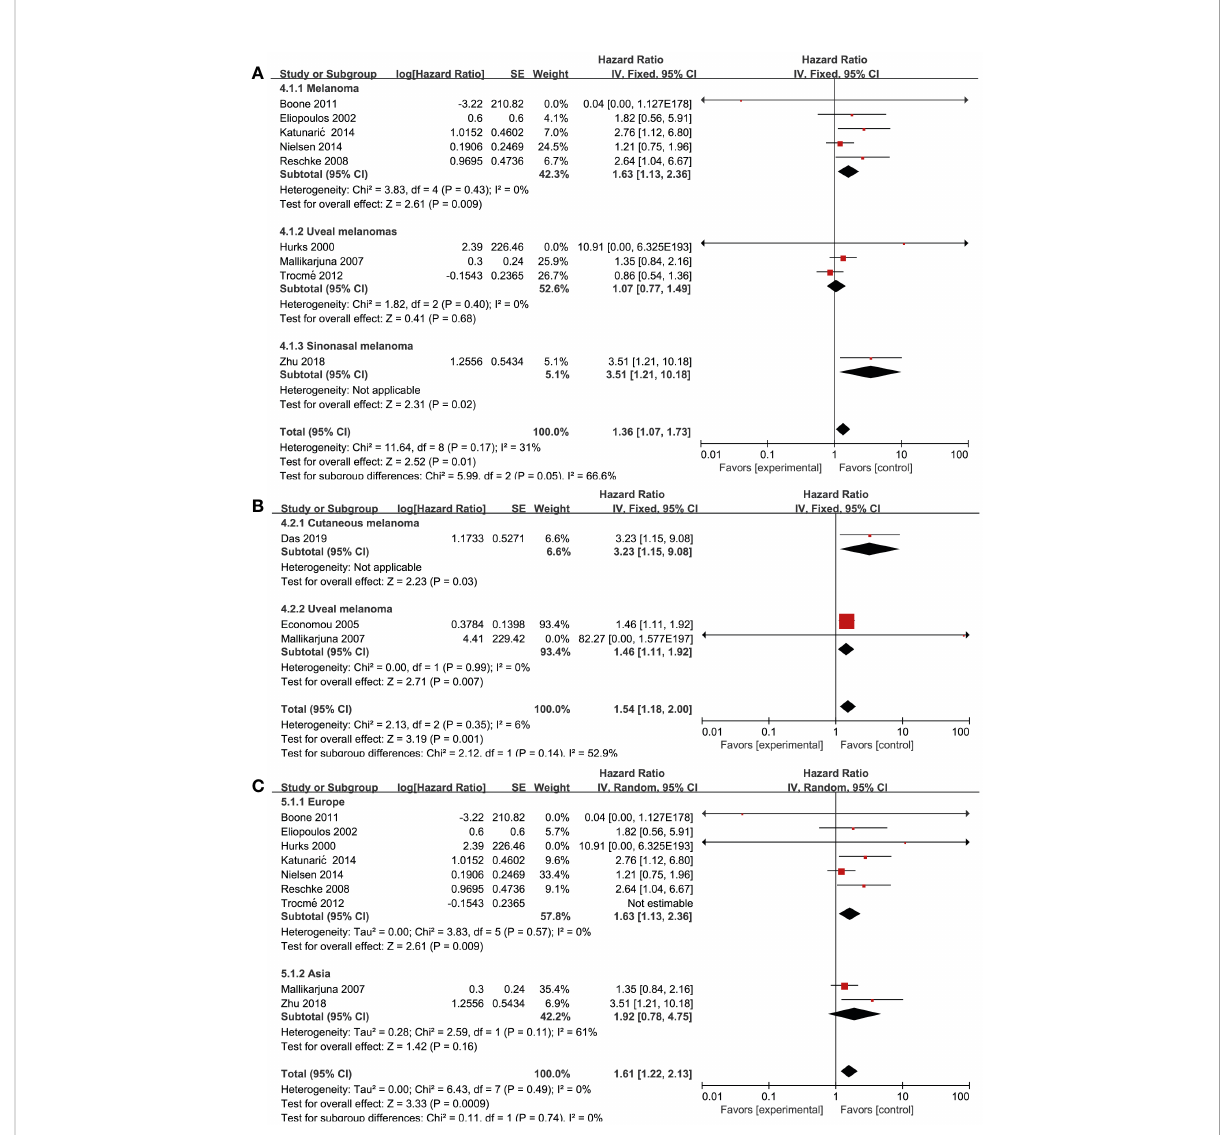
FIGURE 4 Prognosis of various RTK and clinicopathological features. (A) EGFR and disease type, (B) MET and disease type, (C) EGFR and geographical